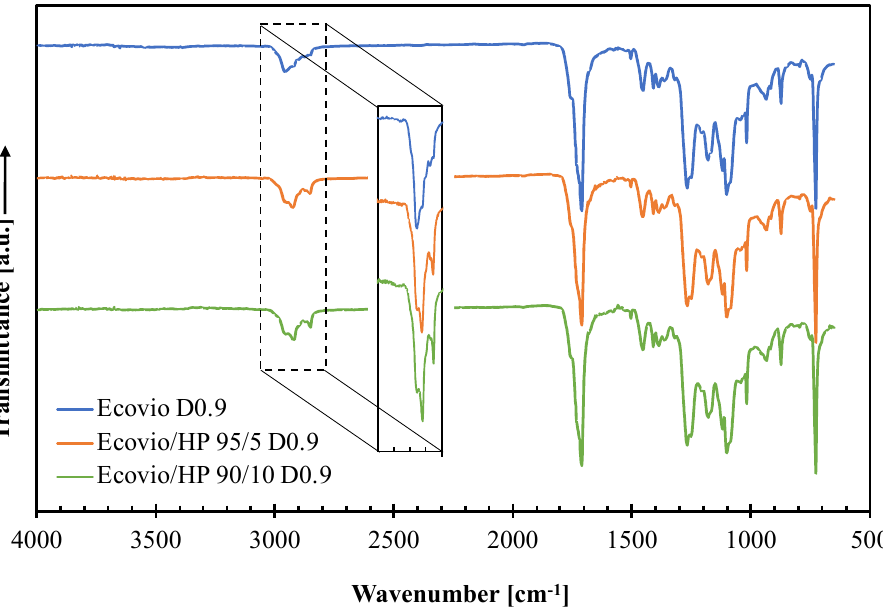
Figure 7. ATR − FTIR curves of Ecovio films produced at different HP loadings (0, 5, 10 wt%) and draw-up speed equal to 0.9 m/min (D0.9).